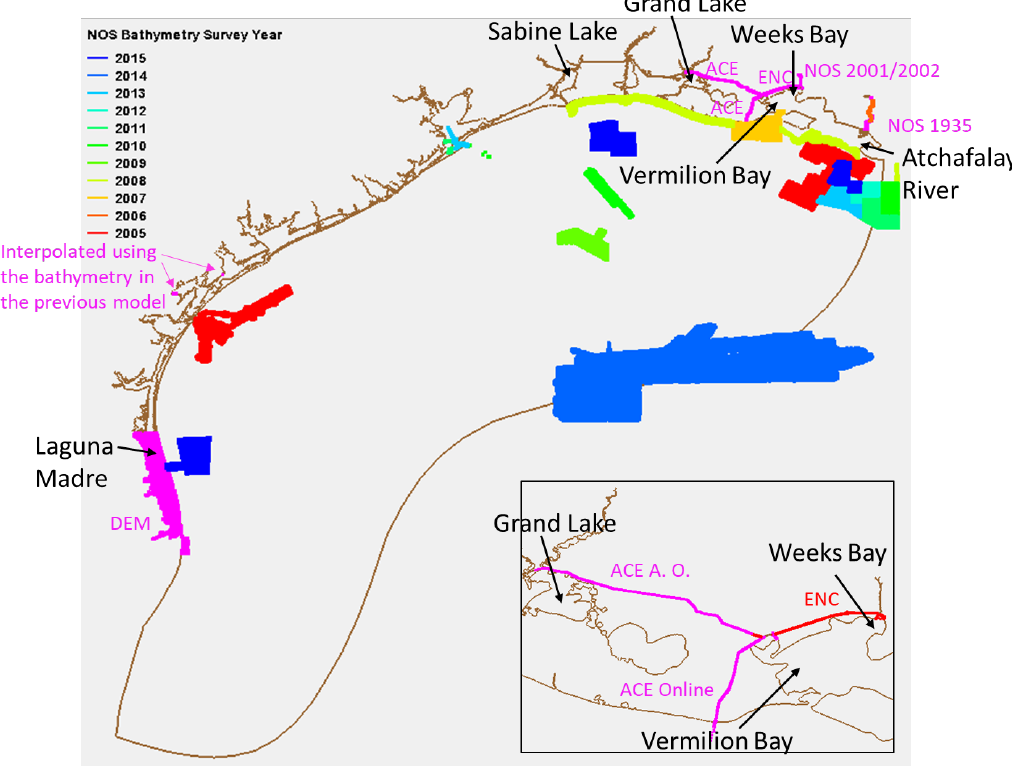
Figure 3. The locations, types, and years of the new bathymetry data used for the model update. The areas with a pink color represent data other than NOS bathymetry. The region with the extended water paths in the western LA’s ICW area is enlarged in the box in the lower right corner to show details. “A. O.” represents data provided by ACE’s Andrew Oakman.